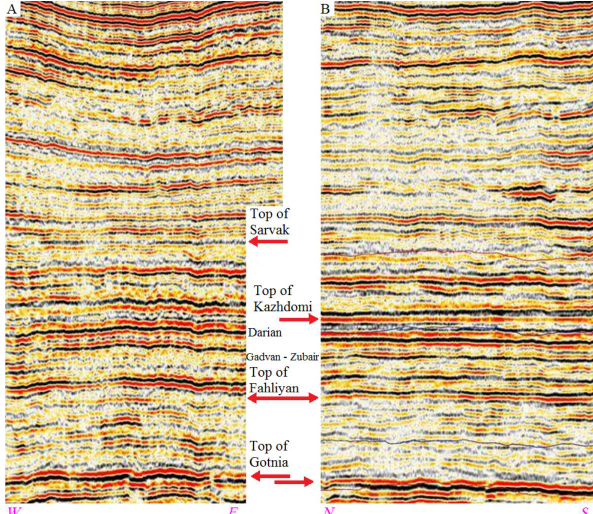
Fig. 1. (a) Seismic line showing flattening at the top of the Sarvak formation. (b) Seismic crossline showing flattening at the top of the Kazhdomi formation (Saadatinejad and Sarkarinejad,